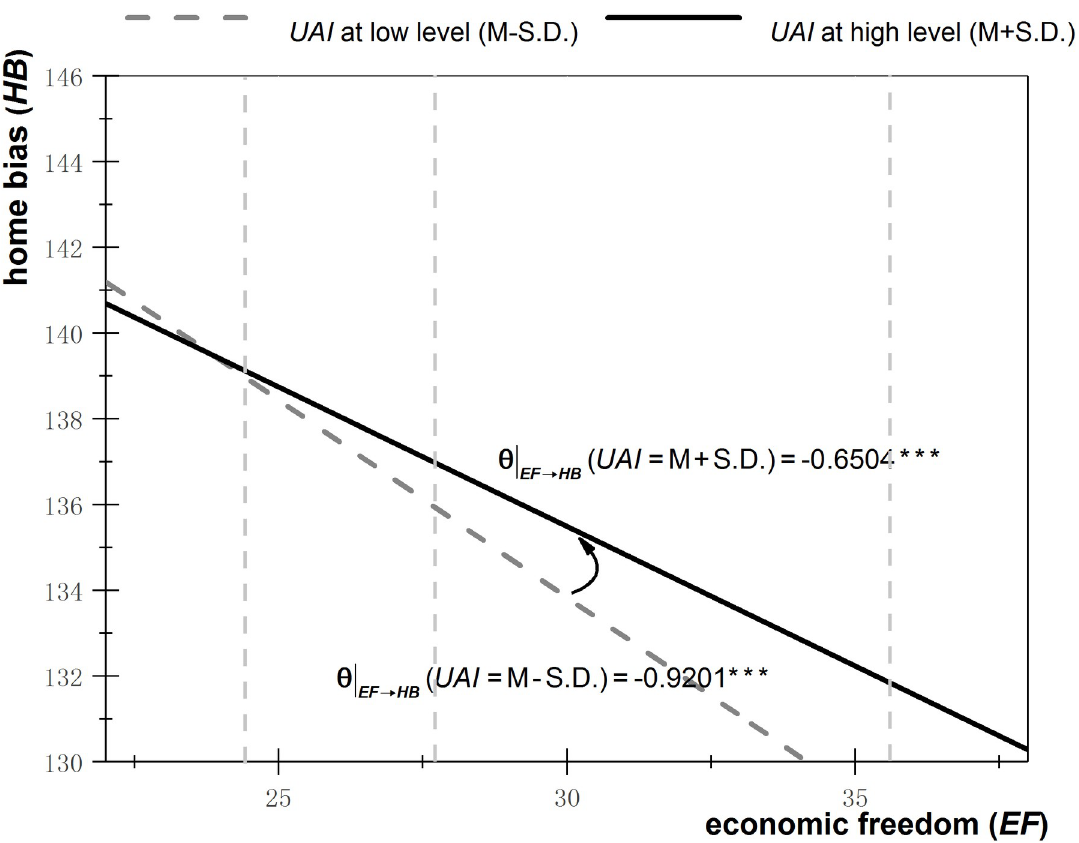
Fig 2. Effects of economic freedom on home bias under different degrees of uncertainty